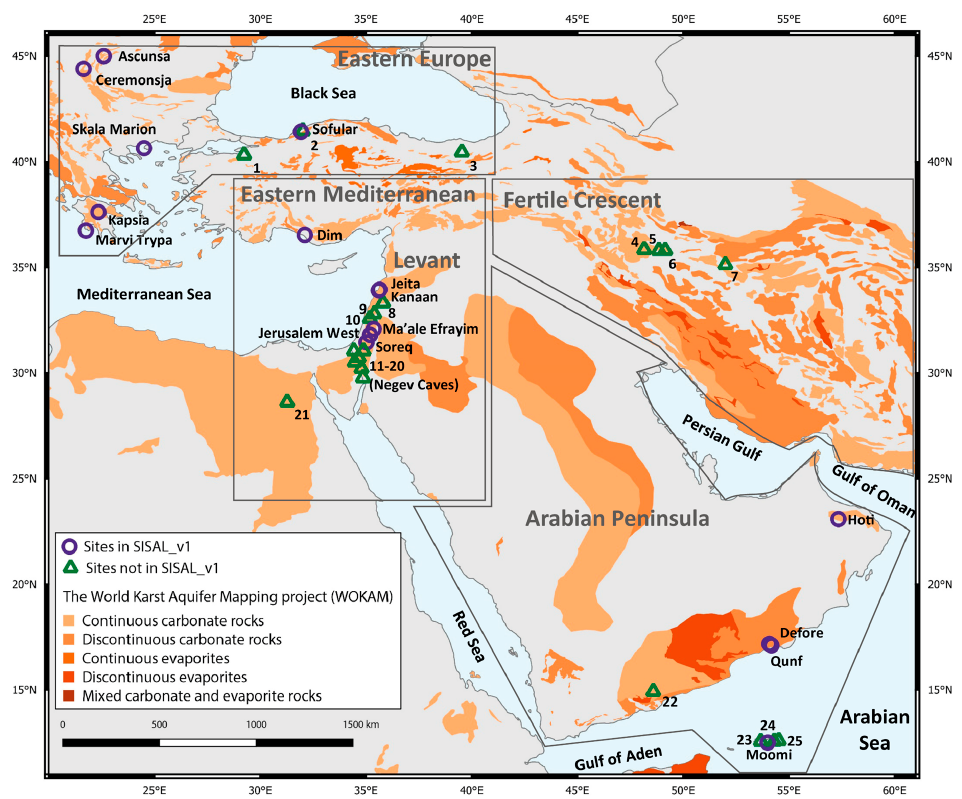
Figure 1. Location of the Middle East (ME) speleothem records that are included in SISAL_v1 (purple circles) and other identified records, not yet included in the database (green triangles). The base map shows the distribution of carbonate and evaporite rocks in the ME, as provided by the World Karst Aquifer Mapping project (WOKAM), adapted with permission from [42]. Cave sites with entities not included in the SISAL database are numbered (Table 1): (1) Karaca (2) Ovacik (3) Akçakale (4) Katleh Khor (5) Qal’e Kord (6) Gejkar (7) Gol-e Zard (8) Mitzpe Shlagim (9) Peqiin (10) Zalmon (11) Ashalim (12) Even Sid (13) Hol-Zakh (14) Izzim (15) Ma’ale Ha-Mishar (16) Ma’ale Dargot (17) Makhtesh ha-Qatan (18) Shizfon mini-caves (19) Tzavoa (20) Wadi Lotz (21) Wadi Sannur (22) Mukalla (23) Dimarshim (24) Casecas (25)